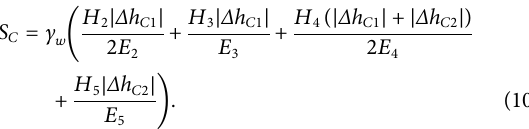
Figure 3 indicates variation of geostatic, hydrostatic and effective stresses as water head drops 40 m in con fi ned